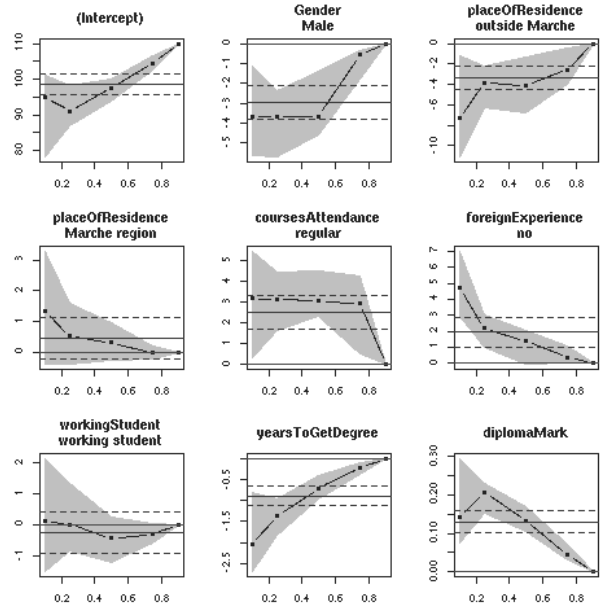
Figure 4 – LS and QR coefficients and related confidence interval for Macerata